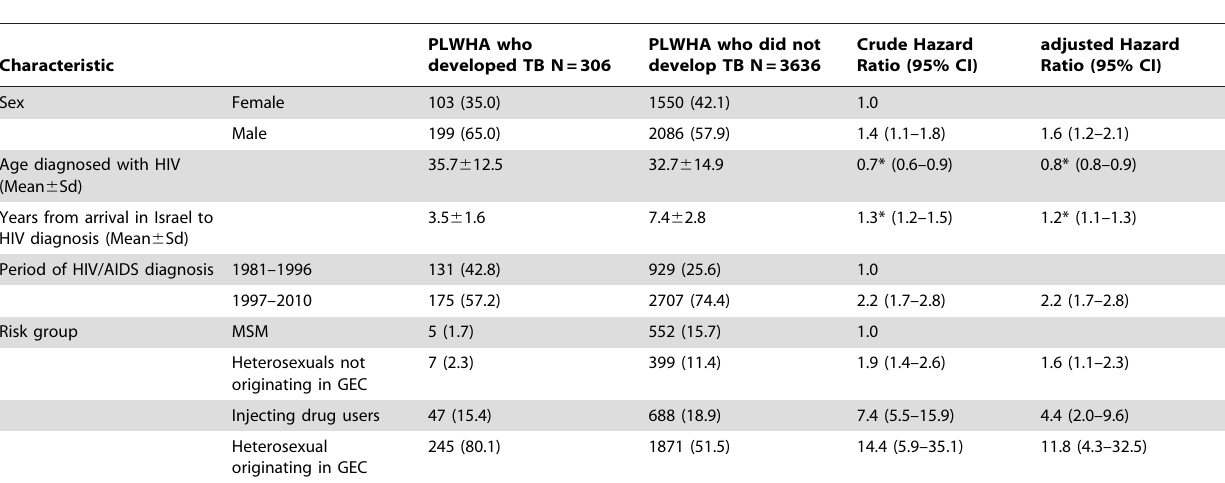
Table 3. Hazard ratios for developing tuberculosis in 3942 non-Israeli born people living with HIV/AIDS reported in Israel in 1983– 2010.